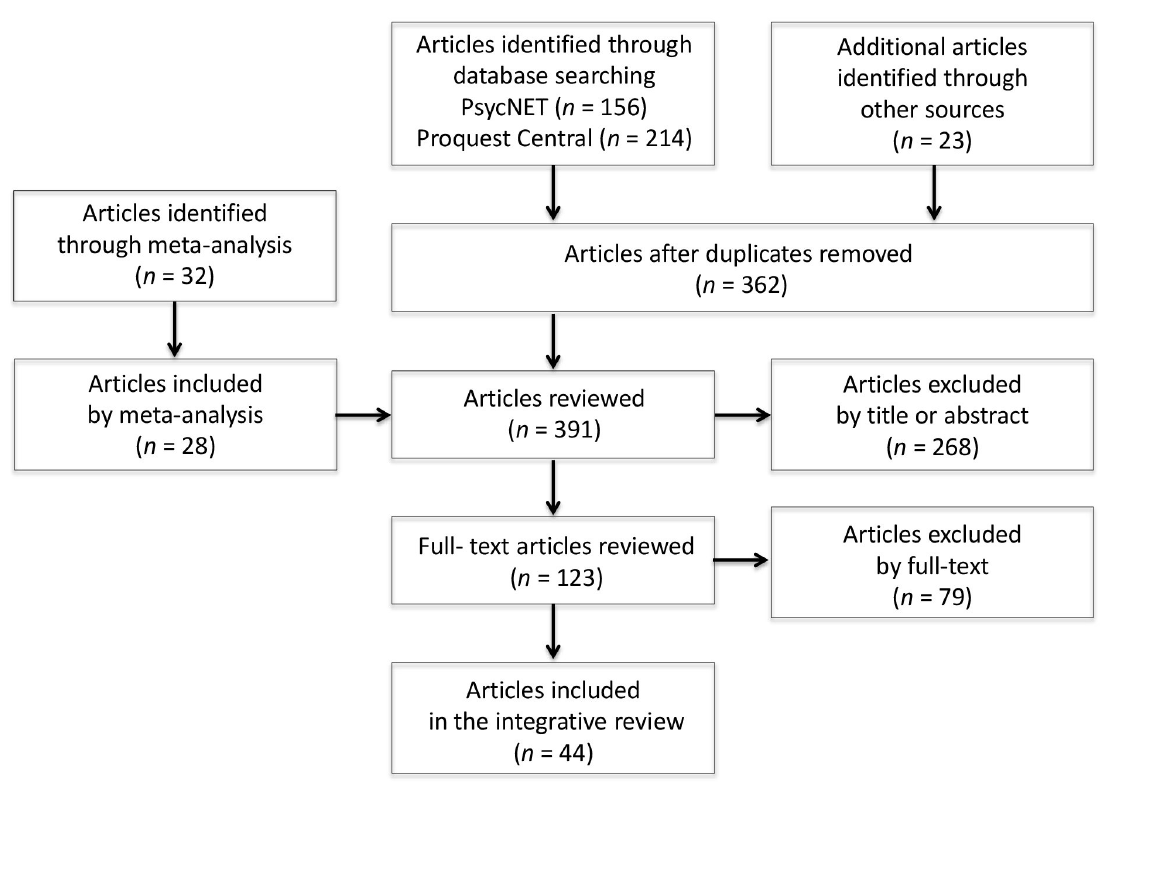
Figure 1. Flow diagram clarifying the literature search and selection